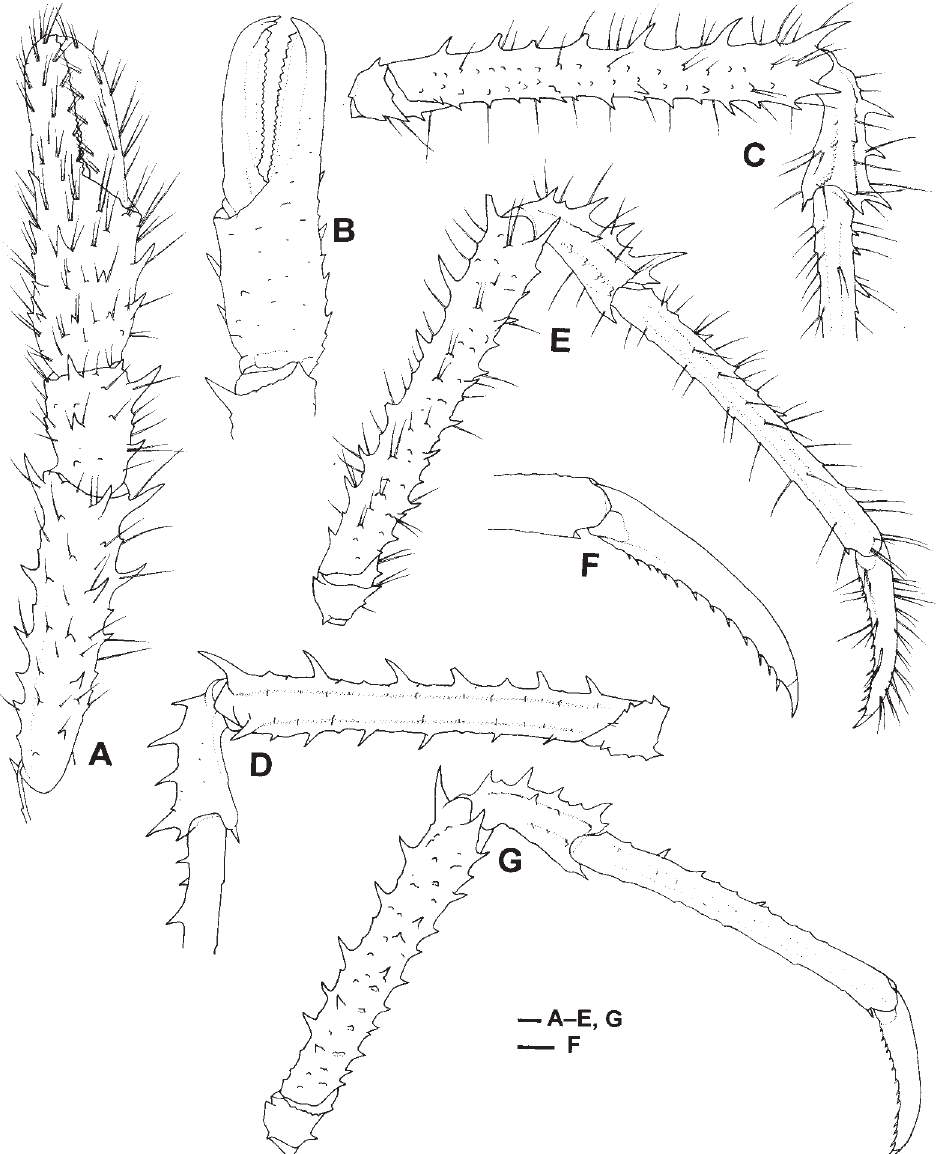
F IG . 4. – Munidopsis echinata n. sp., holotype female (cl 19.7 mm). A, left first pereopod, dorsal view; B, same, chela and distal part of carpus, ventral view; C, right second pereopod, lateral view (distal articles broken); D, same, mesial view (setae omitted); E, right third pere- opod, lateral view; F, same, dactylus and distal part of propodus, lateral view (setae omitted); G, right fourth pereopod, lateral view (setae omitted). Scales equal 1.0